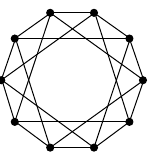
Figure 1. The circulant C 10 ( 1,3 )